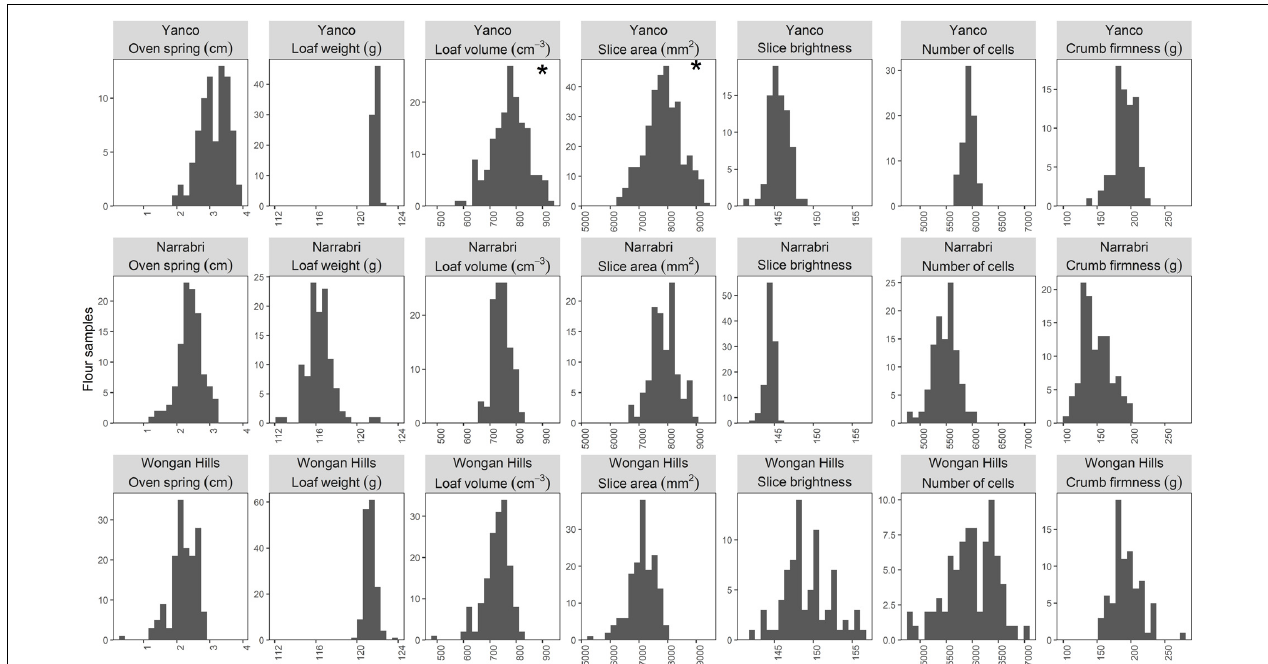
FIGURE 2 | Milled sample-level BLUP distributions for the baking quality traits for the Yanco, Narrabri, and Wongan Hills sites are presented as histogram. Subplots marked with an asterisk display raw trait data as the LMM analysis was unable to estimate any non-negligible variation between milled